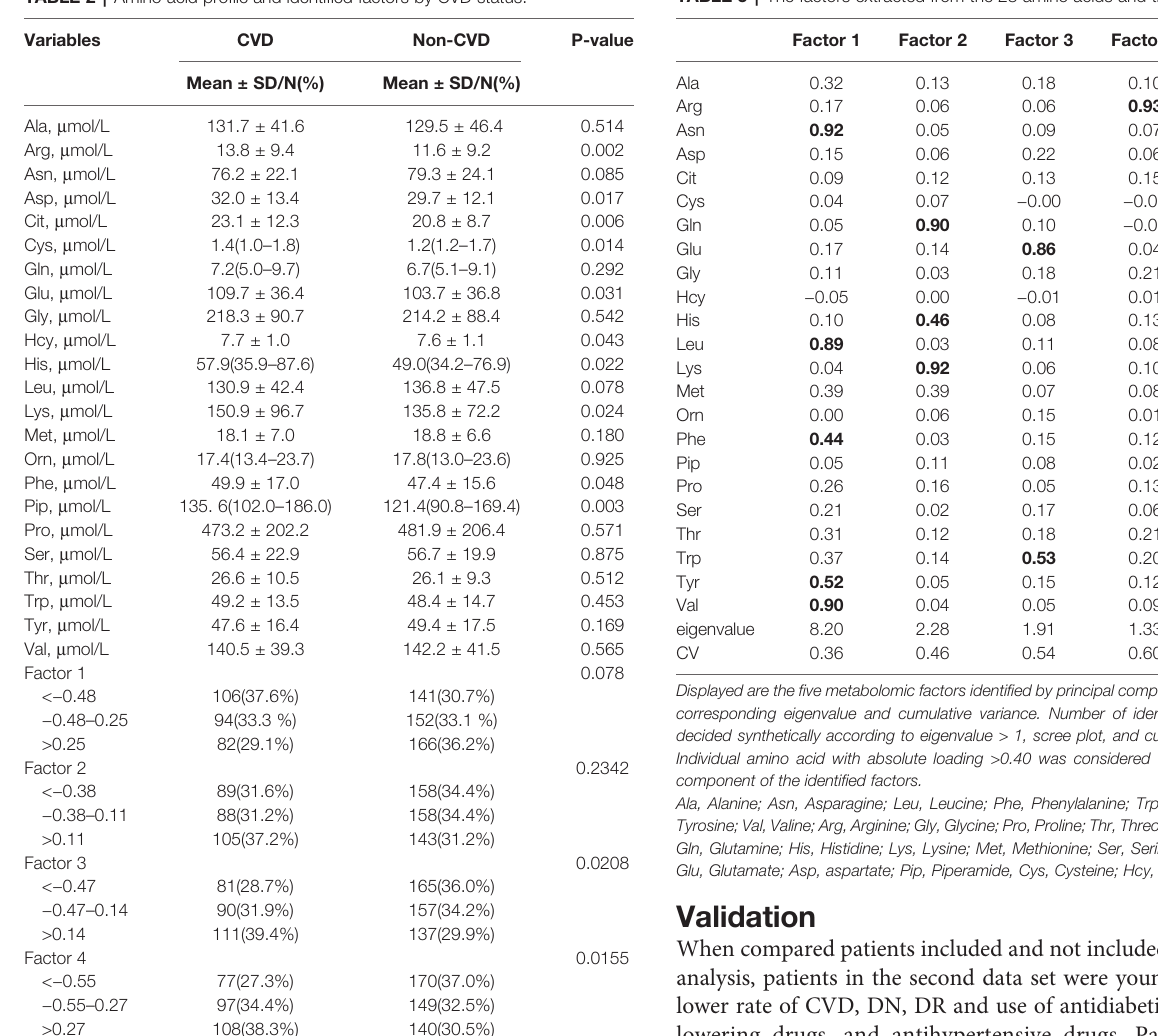
TABLE 3 | The factors extracted from the 23 amino acids and their